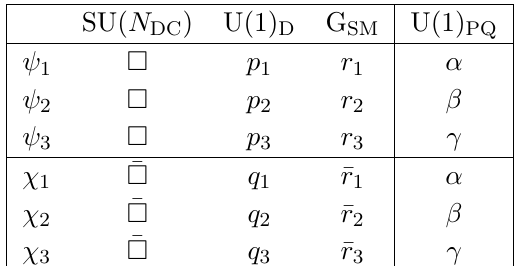
Table 4 . Composite axion model with n f = 3 . The representations r 1 , r 2 , r 3 are assumed to be irreducible, and G is either the SM gauge group or one of its GUT extensions. The U(1) SM are defined so that p = p , q = q for i 6 = j and can be normalized to be all integer numbers. i 6 j i 6 j